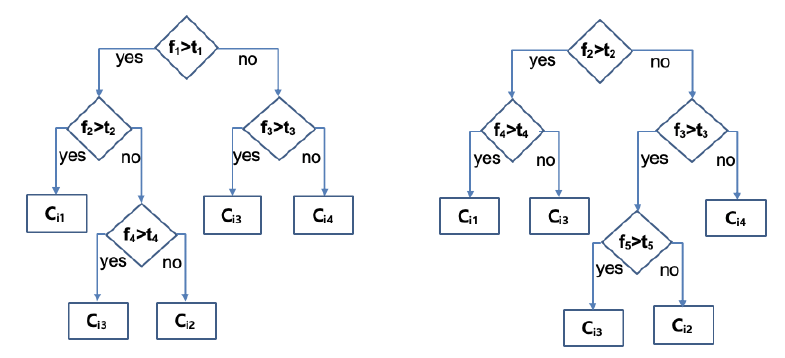
Figure 3. Example of RF: an ensemble of 2 decision trees (DTs) with a depth of 4 on 5